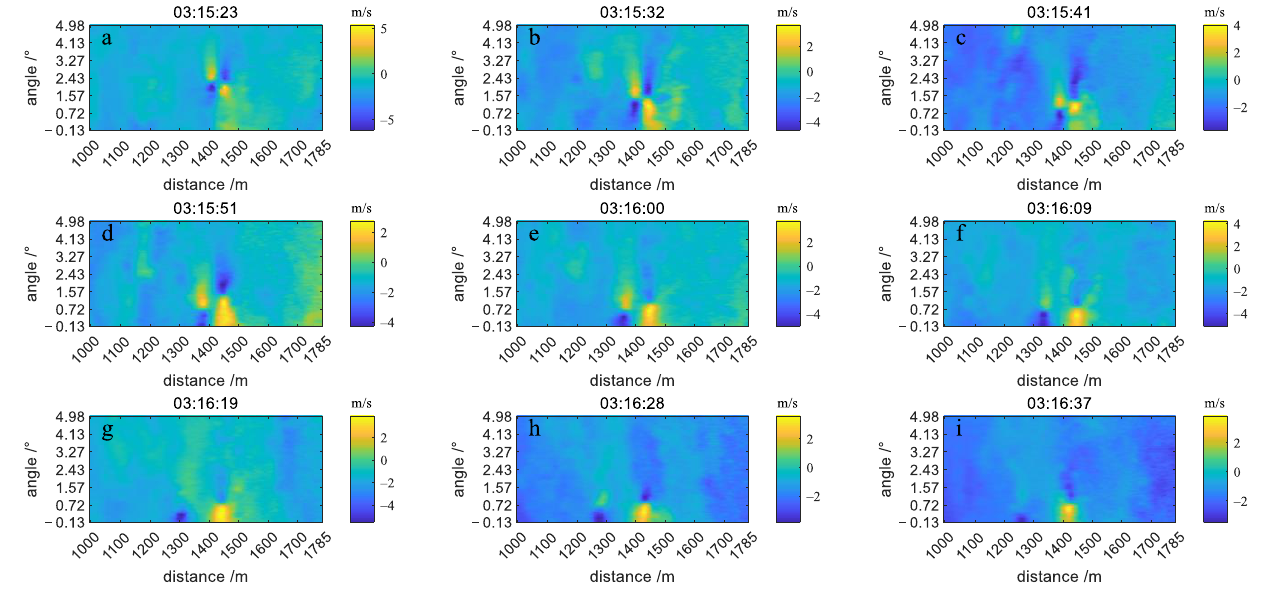
Figure 3. Lidar maps demonstrating the aircraft wake evolution. ( a – c ) Early stage; ( d – f ) middle stage; ( g – i ) late stage.